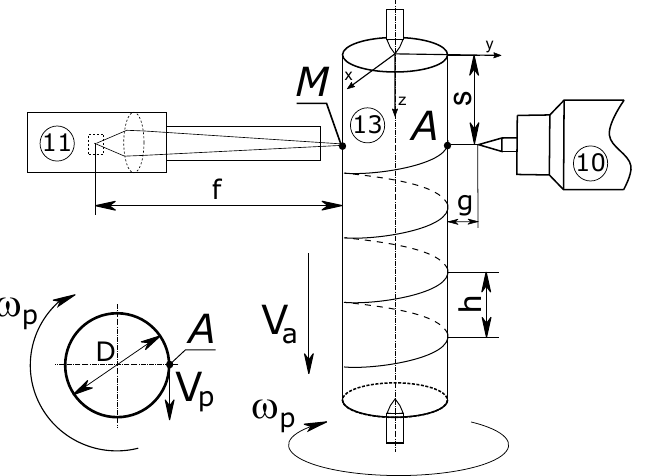
Figure 2. Scheme of the analysed task: 10, heat source; 11, measuring system; 13, analysed sample. The temperature measurement system consisted of a RAYTEK MI3 pyrometer equipped with a measuring head MI31002MSF1 (element 11, 12, Figure 1) [18]. The control system of the experimental stand was based on the PLC controller and HMI panel. The PLC controller consists of a main unit FATEK FBs-24MCJ2-D24 (element 2, Figure 1) equipped additionally with two expansion units: a six channel analog to digital converter (FATEK Fbs-6AD)